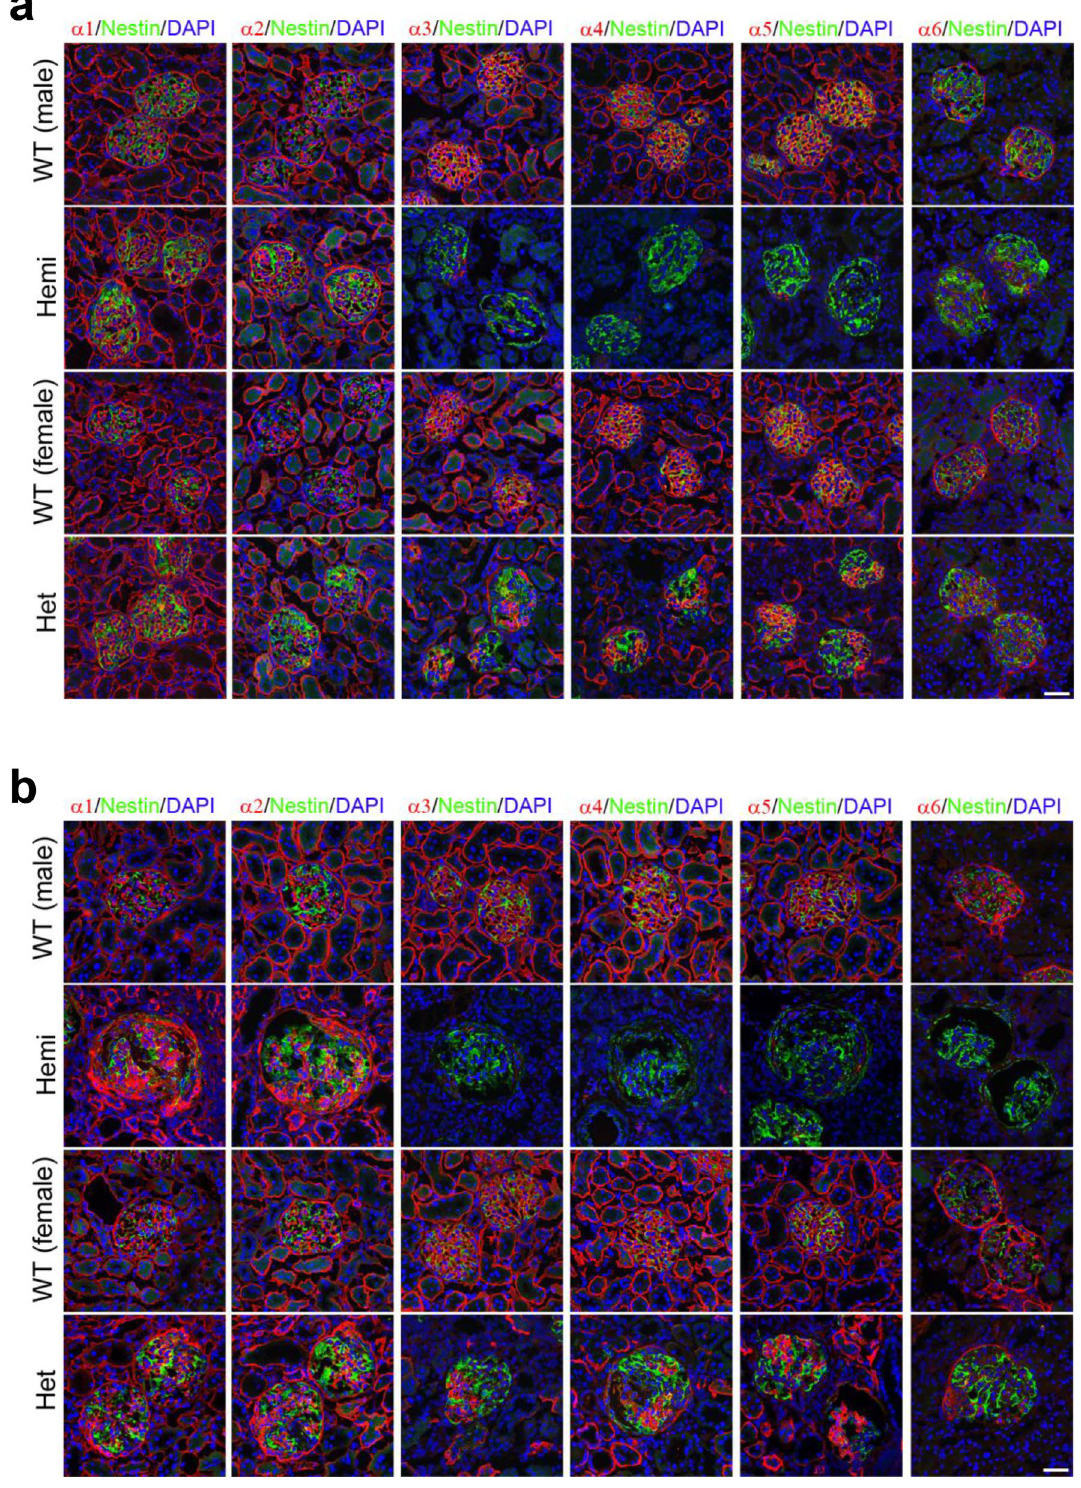
Figure 7. Type IV collagen distributions in Col4 α 5 deficient kidneys. (a,b) Immunofluorescence analyses of kidney sections with antibodies against α1-6 (IV) (red), nestin (green; glomeruli), and DAPI (blue; nuclei) in wildtype (WT) and Col4α5 mutant (Hemi; hemizygous males, Het; heterozygous females) rats at 8 weeks (a) and 20 weeks (b) of age. Scale bars , 50